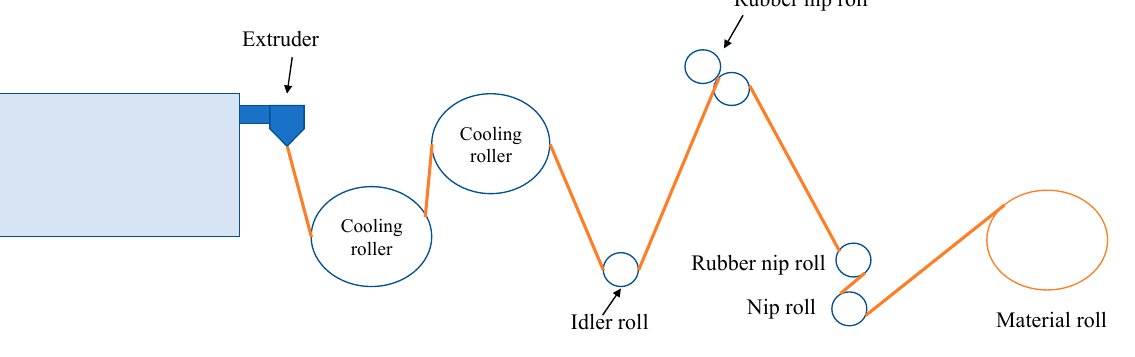
Figure 7. Scheme of the extrusion process.